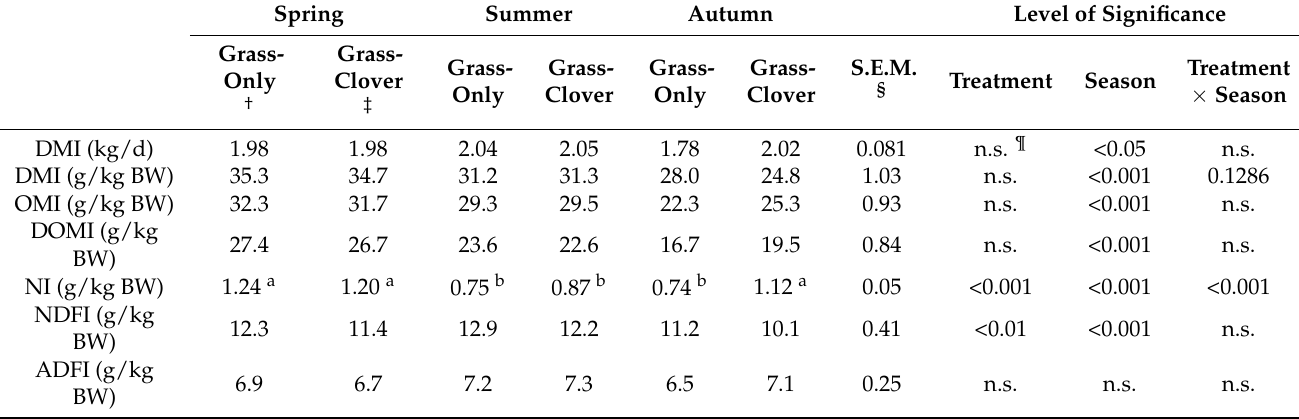
Table 3. Effect of forage type (grass-only and grass-clover) offered to individually housed sheep in spring (27 March–29 April), summer (19 June–22 July) and autumn (4–29 September) on voluntary dry matter intake (DMI) per body weight (BW), digestible organic matter intake (DOMI) and intake of chemical components. LSMeans for the interaction are presented. Spring Summer Autumn Level of Significance Grass- Grass- Grass- Grass- Grass- Grass- Only Clover Only Clover Only Clover † ‡